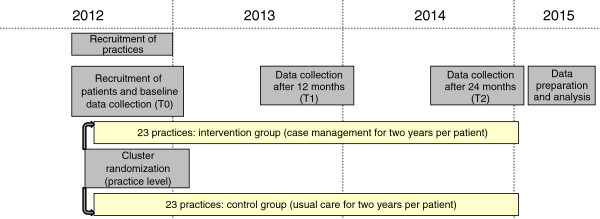
Description of schedule and expected duration of the PICANT trial.